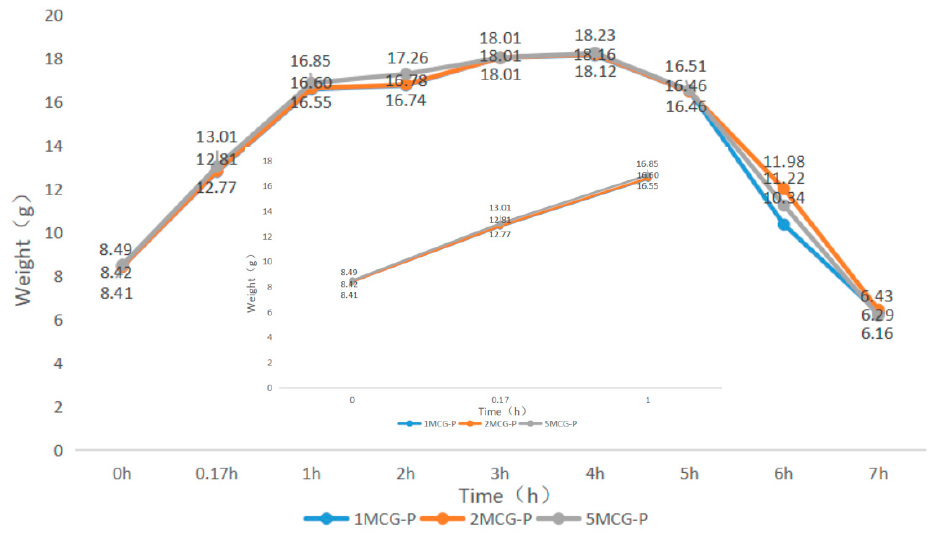
Figure 9. Swell property of CS/Gel/MMT/PCL bone scaffolds. 3.2.5. Porosity Measurement of CS/Gel/MMT/PCL Bone Scaffolds